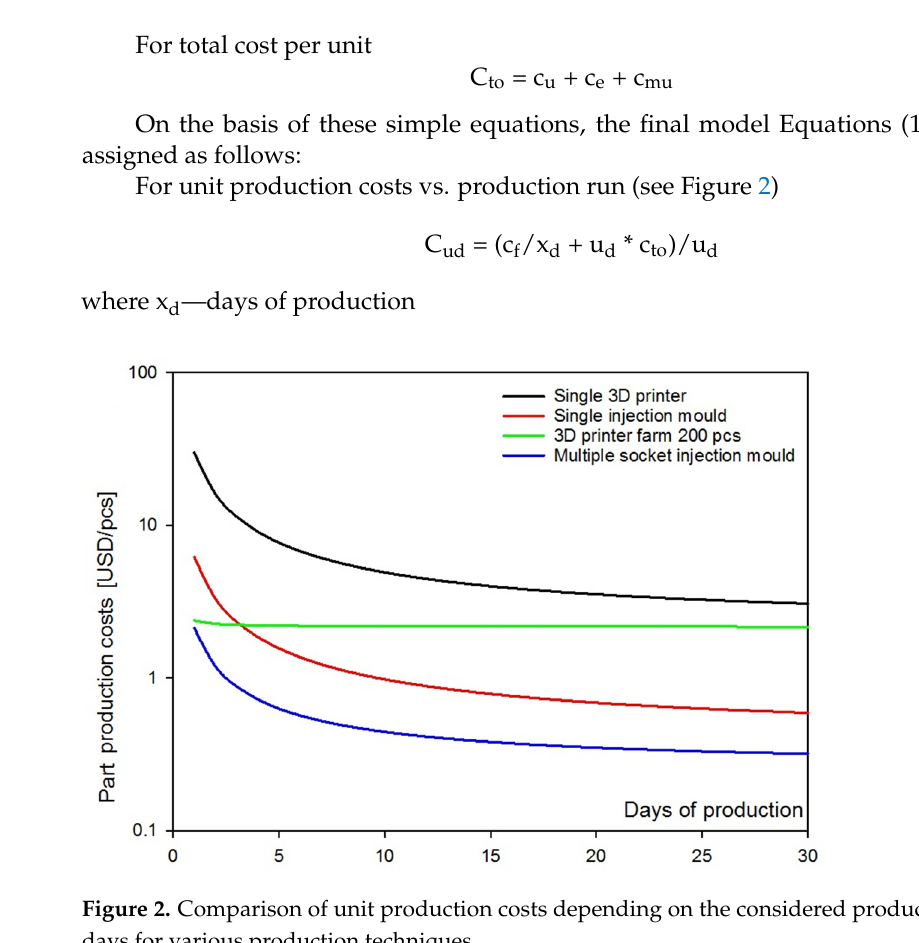
Figure 2. Comparison of unit production costs depending on the considered production period in days for various production techniques.